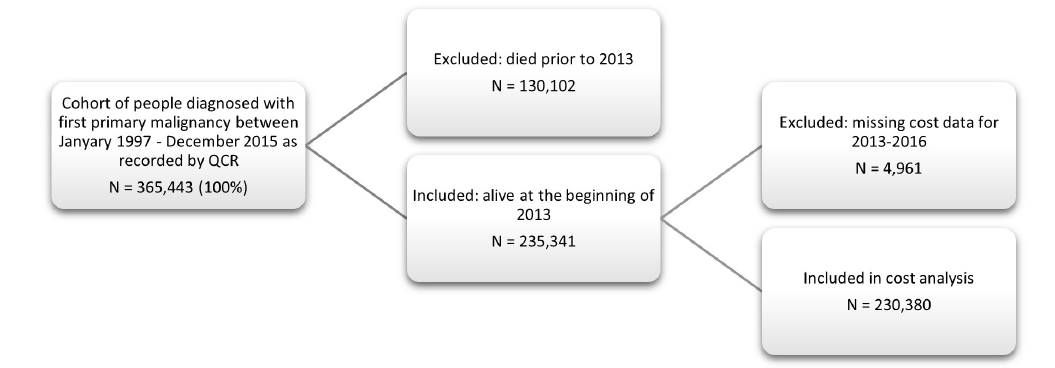
Figure 1. Flowchart for Selection of Queensland Cancer Cohort.